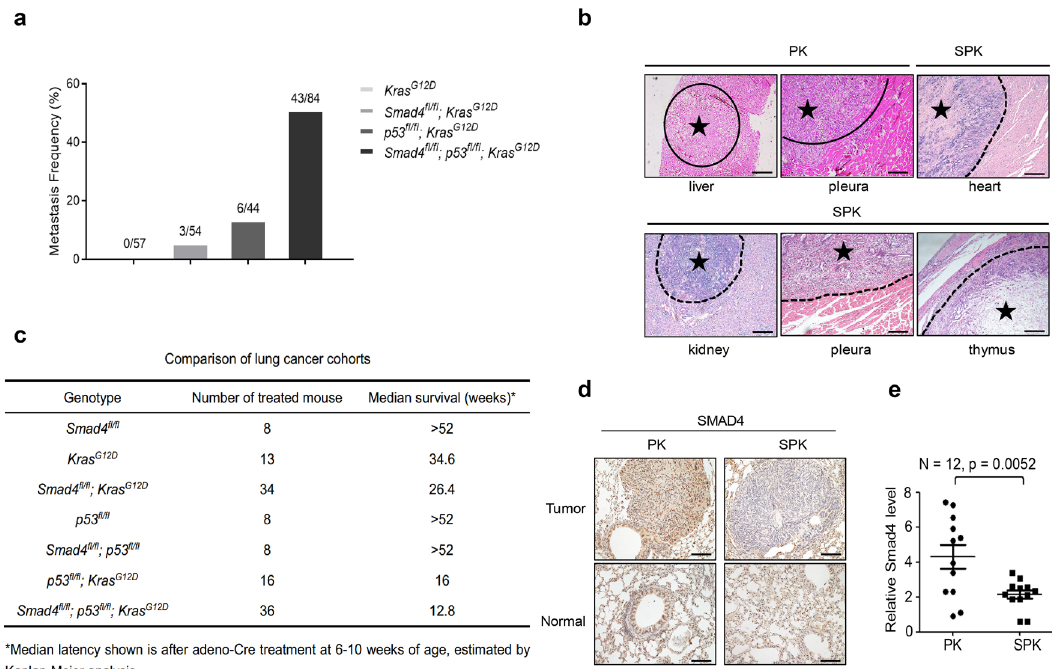
Fig. 1 Smad4 deletion accelerates lung tumorigenesis and metastasis. a Statistical analyses of lung cancer metastases frequency in KRAS G12D ( n = 57), Smad4 fl / fl ; KRAS G12D ( n = 54), p53 fl / fl ; KRAS G12D ( n = 44), Smad4 fl / fl ; p53 fl / fl ; KRAS G12D ( n = 84) mice. b Representative images of H&E stained lung cancer metastatic tissues, including liver, pleura from PK mouse and heart, kidney, pleura, thymus from SPK mouse. Similar H&E staining results were observed in a group of mice, whose information is listed in Supplementary Data 5. Asterisk indicates the area of metastatic tumors. Scale bar, 100 μ m (magni fi cation, ×10). c Survival statistics of different genotype mice with lung cancer. Median latency refers to the survival time on average (in weeks) after adeno-Cre treatment at the age of 6 – 10 weeks, estimated by Kaplan – Meier analysis. d Representative IHC staining of Smad4 on normal and lung tumor sections of PK or SPK mice. Mice were all treated by adeno-Cre for 14 weeks. Scale bar, 25 μ m (magni fi cation, ×40). e The Smad4 mRNA expression of PK and SPK mouse lung tumors was evaluated by real-time quantitative PCR. n = 12; data represent means ±SEM; as determined by two-tailed Student ’ s t